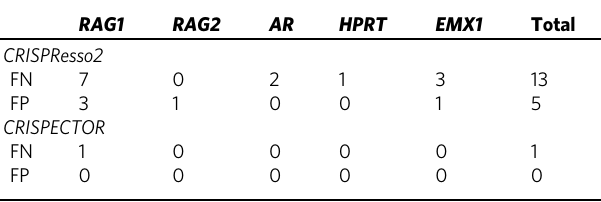
Table 2 CRISPResso2 and CRISPECTOR errors per